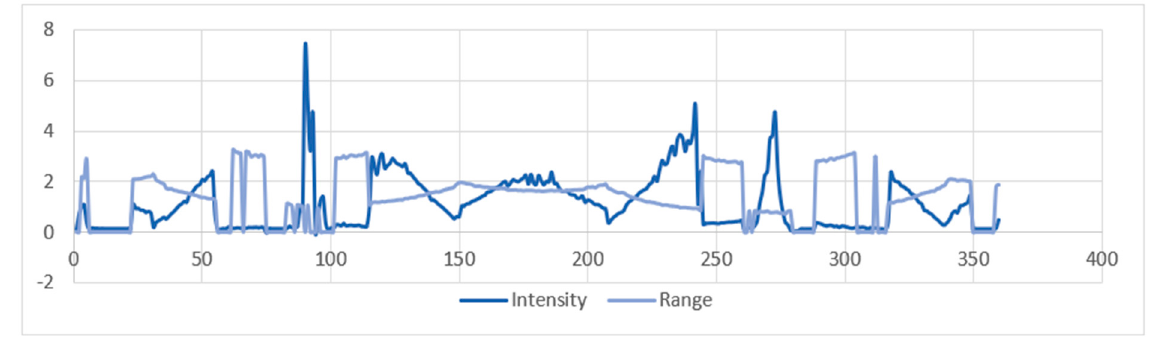
Figure 21. The 360 received intensity laser scan points mapped linearly for the Figure 20.